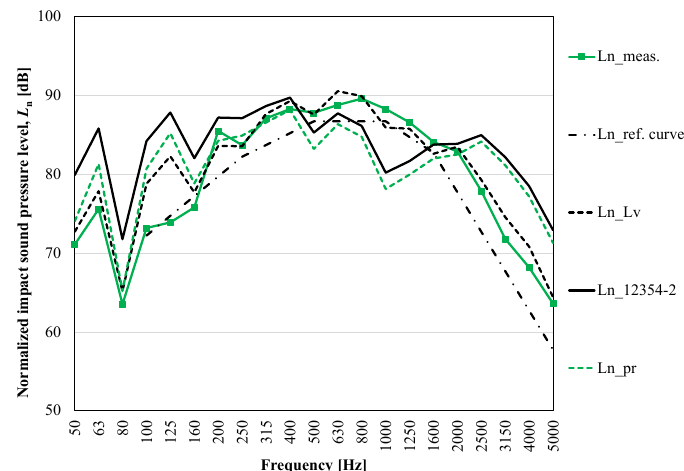
Figure 17. Measured and predicted normalized impact sound pressure level.